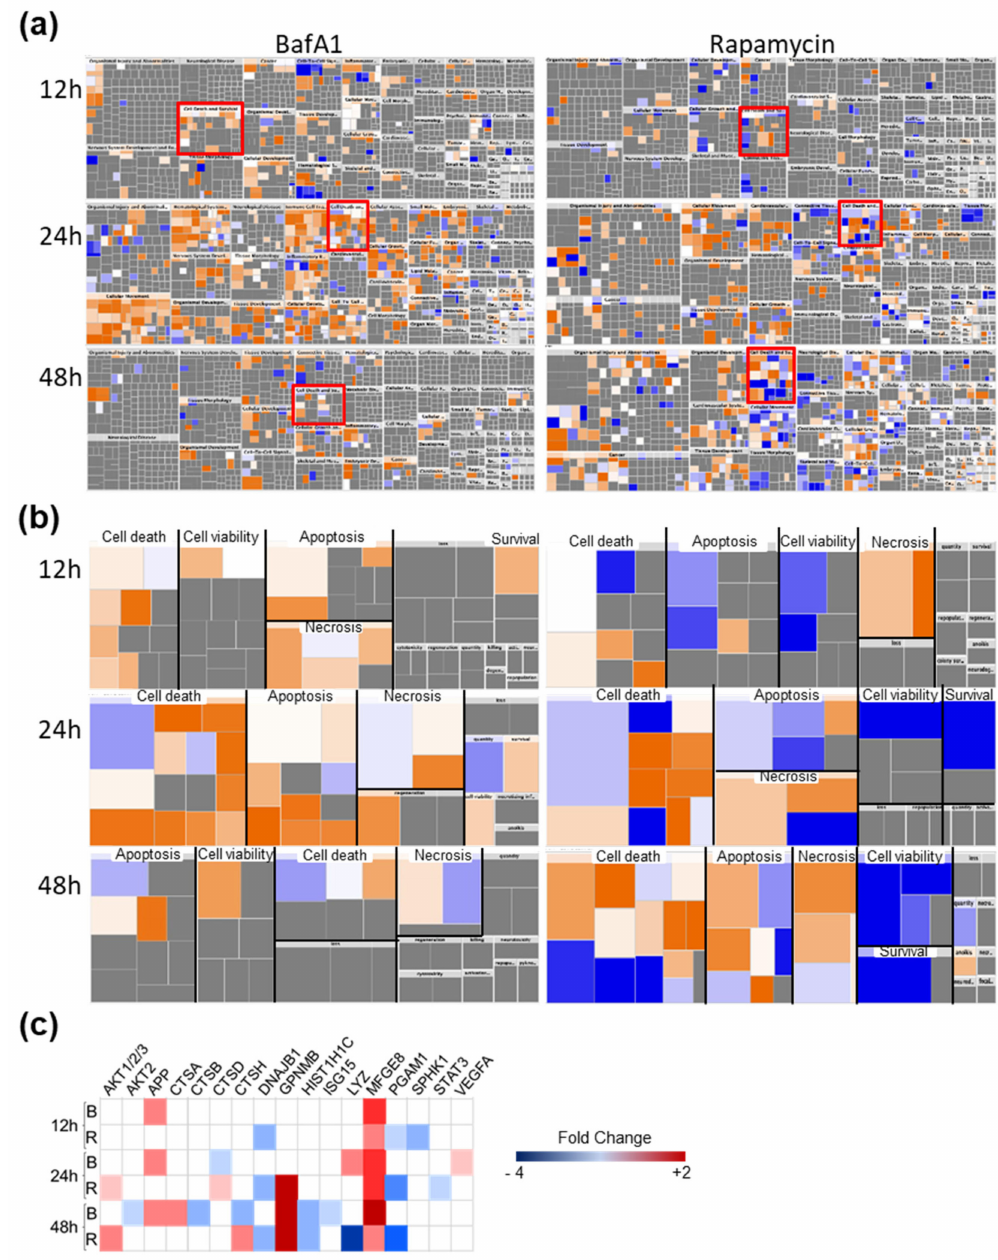
Figure 3. Global dysregulation of U-251 proteins induced by Bafilomycin (BafA1) and Rapamycin (Rapa) treatment. U-251 cells were treated with the drugs for the indicated amounts of time, then cellular proteomes probed by SOMAscan ® and compared to non-treated time-matched samples. ( a ) Global Ingenuity Pathway Analysis (IPA) default-determined alterations in “Diseases and Functions”. The “Cell Death and Survival” categories in ( a ) are enclosed in red boxes and expanded in ( b ). ( b ) Expanded Cell Death and Survival categories with each sub-category “Apoptosis”, “Cell death”, “Cell viability”, “Necrosis” and “Survival” separated. Each colored block within each sub-category refers to specific cellular nodes. Up-regulated (activated) nodes are indicated in orange; down-regulated (inhibited) by blue; not significantly regulated in grey. ( c ) Significantly dysregulated proteins associated with autophagy induced by BafA1 (B) or Rapamycin (R). Determinations based on three biological